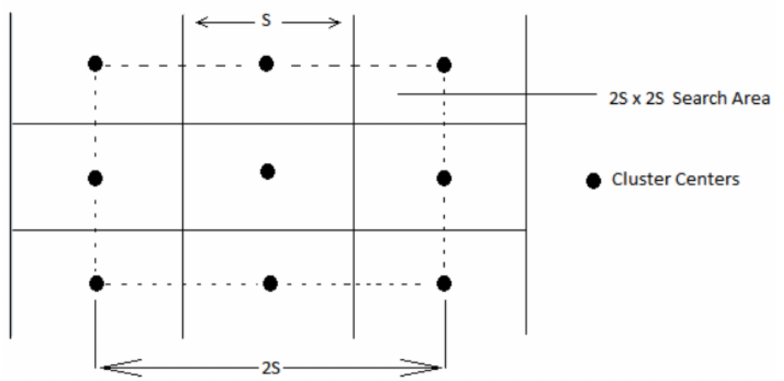
Figure 2. Restricted Image search area for super-pixel creation specified by input argument for image window under consideration